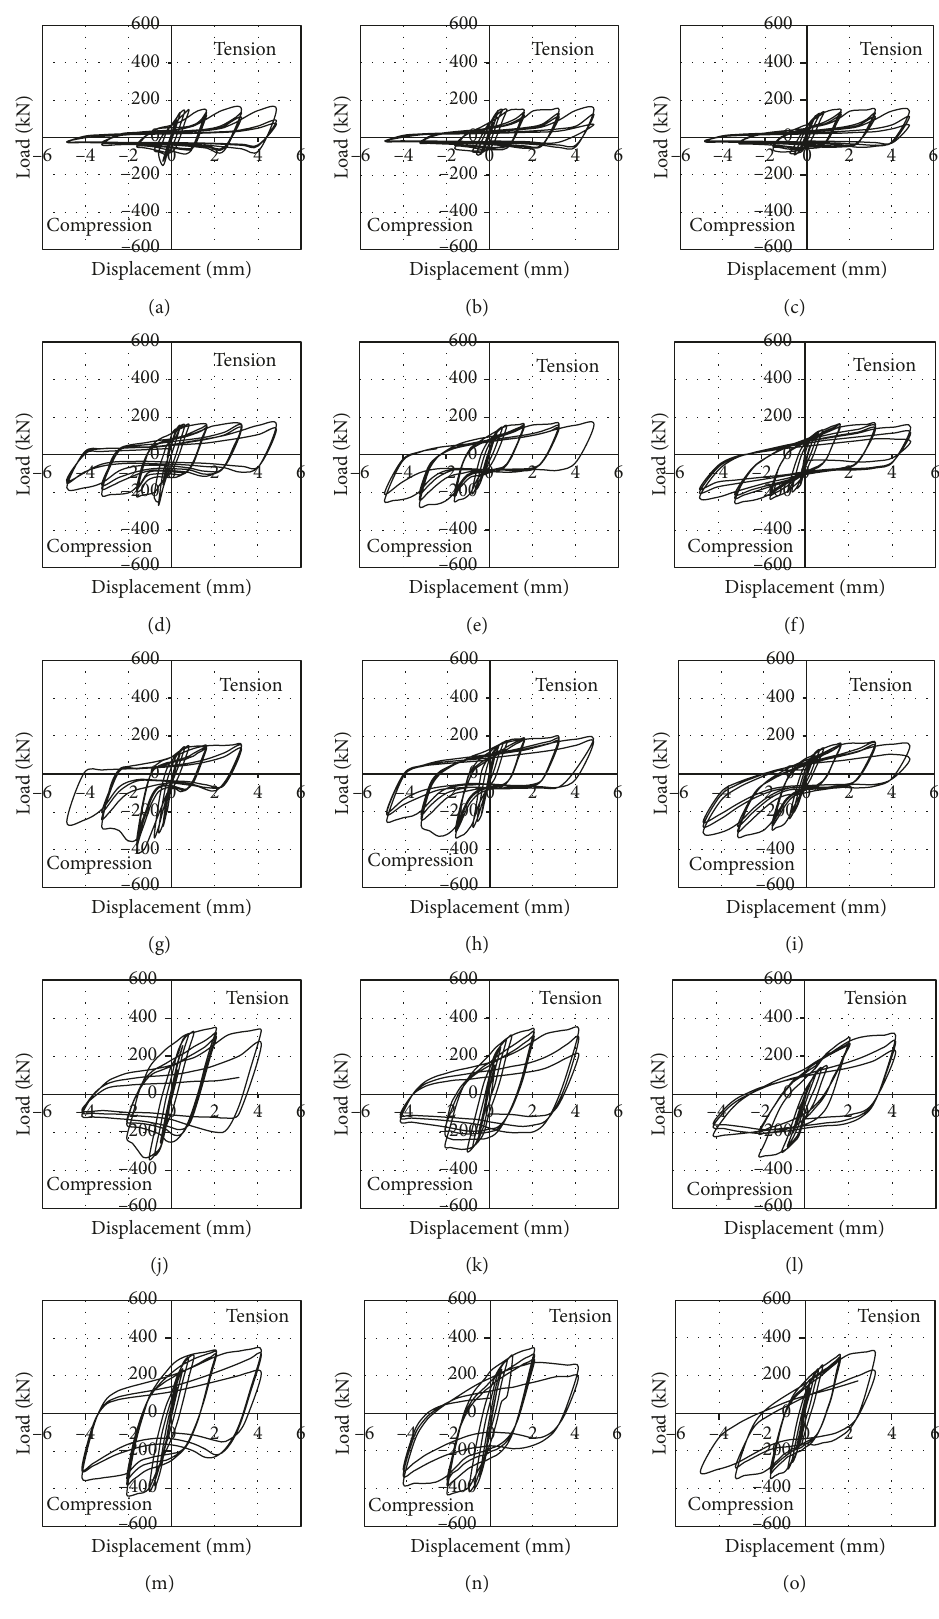
Figure 7: Hysteretic loop. (a) T1.8C0A0. (b) T1.8C0A4. (c) T1.8C0A9. (d) T1.8C20A0. (e) T1.8C20A4. (f) T1.8C20A9. (g) T1.8C40A0. (h) T1.8C40A4. (i) T1.8C40A9. (j) T3.0C0A0. (k) T3.0C0A4. (l) T3.0C0A9. (m) T3.0C20A0. (n) T3.0C20A4. (o)